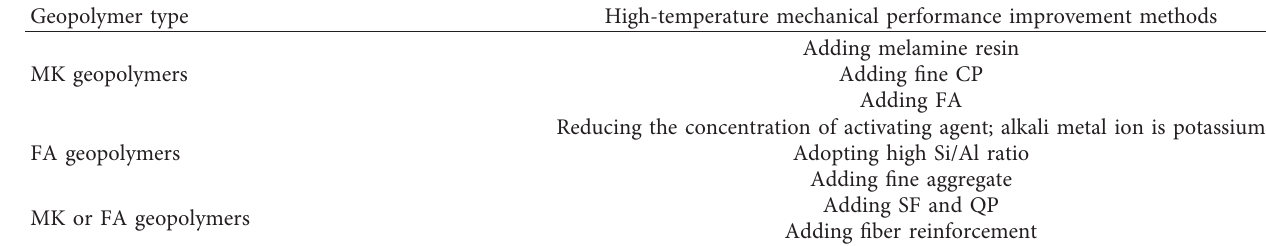
Table 8: Summary of methods for improving residual strength of geopolymers. Geopolymer type High-temperature mechanical performance improvement